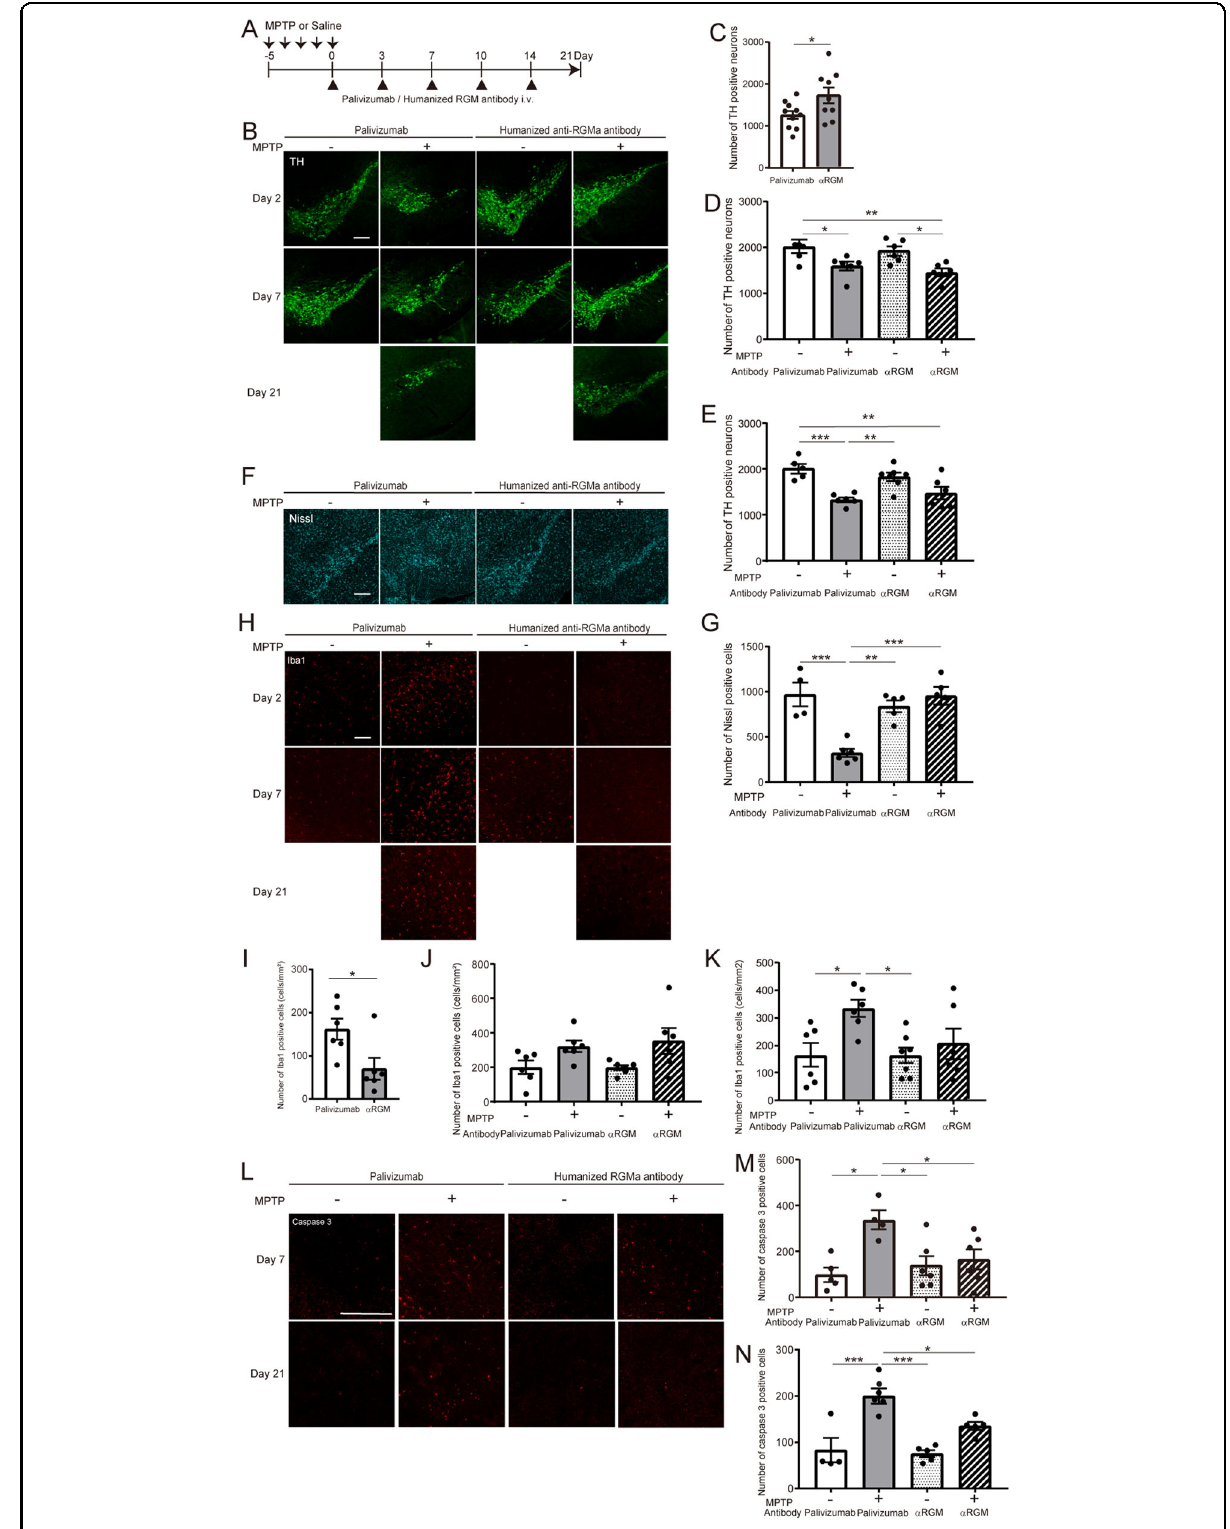
Fig. 3 (See legend on next